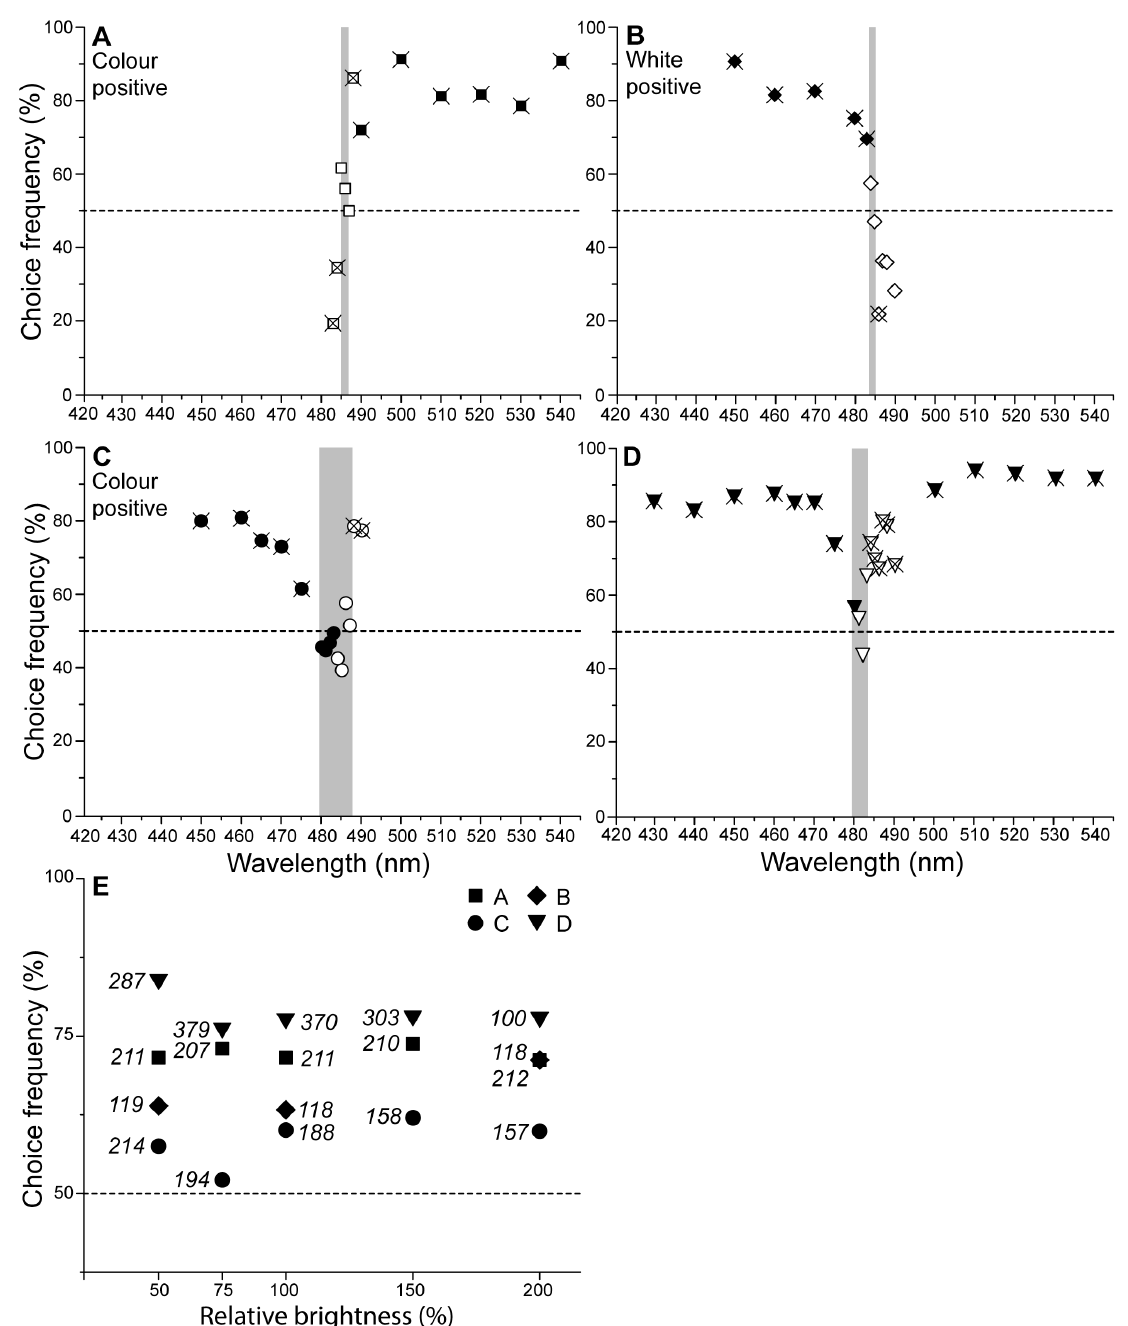
Figure 5. Discriminability in the wallaby shows a Neutral Point where white is indistinguishable from colour stimuli. Open symbols represent non-reinforced transfer trials. Crosses denote statistical significance , 5%. (A) Responses when choice of the coloured light was rewarded over the white light for colours above 480 nm (n=1051). Choices at wavelengths 485 nm–487 nm were not significant, indicated by the grey vertical bar. (B) Responses when the wavelength range was shifted to 450 nm–490 nm and choice of white was rewarded over colour stimuli. Performance was not significant for wavelengths 484 nm and 485 nm, as well as 487 nm, 488 nm, and 490 nm (n=355). The possible range containing the Neutral Point is indicated by the grey vertical bar. (C) Colour discrimination performance after a reversal in reward rules for the wavelength range 450 nm– 490 nm (n=911). The choice of short-wavelength monochromatic stimuli was rewarded over white. The preference of colours over the white light on both sides of the proposed Neutral Point (grey bar) indicates the use of an absolute colour discrimination rule. (D) Colour discrimination over an extended wavelength range of 430 nm–540 nm where choice of the colour stimuli was rewarded over white. Responses show that monochromatic lights could be discriminated from white light for both short and long wavelength colours (n=1439), but not for colours around 4850 nm–483 nm. (E) Responses in the Neutral Point experiment were independent of stimulus brightness. Average choice frequencies did not change systematically with the brightness level at which the colour stimulus was presented against the white light in any of the four experimental stages A–D. Italic numbers give sample sizes per data point.